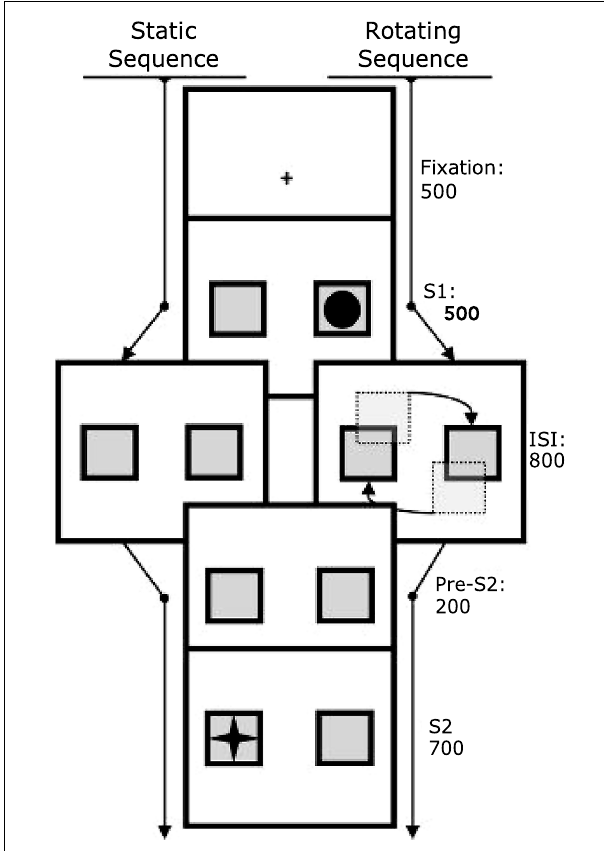
FIGURE 2 | Schematic depiction of the trial-sequence of two example trials. After presenting a fixation crosshair, two boxes were presented for 500 ms in the left and right of the screen, one containing the shape (S1) to which participants were required to respond. In the “static” condition (left), an inter-stimulus interval (ISI) followed in which the boxes stood still for 800 ms, whereas in the rotating condition, they rotated around their axis during this ISI. In both conditions, the boxes were statically presented for another 200 ms before the second target (S2) was shown. S2 was shown for 700 ms before an inter-trial interval of 1100 ms ended the